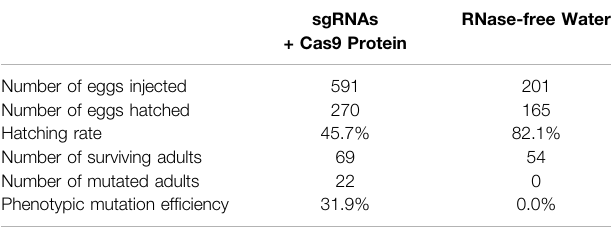
TABLE 1 | Summary of the cinnabar mutagenesis mediated by four sgRNAs in Tuta absoluta .